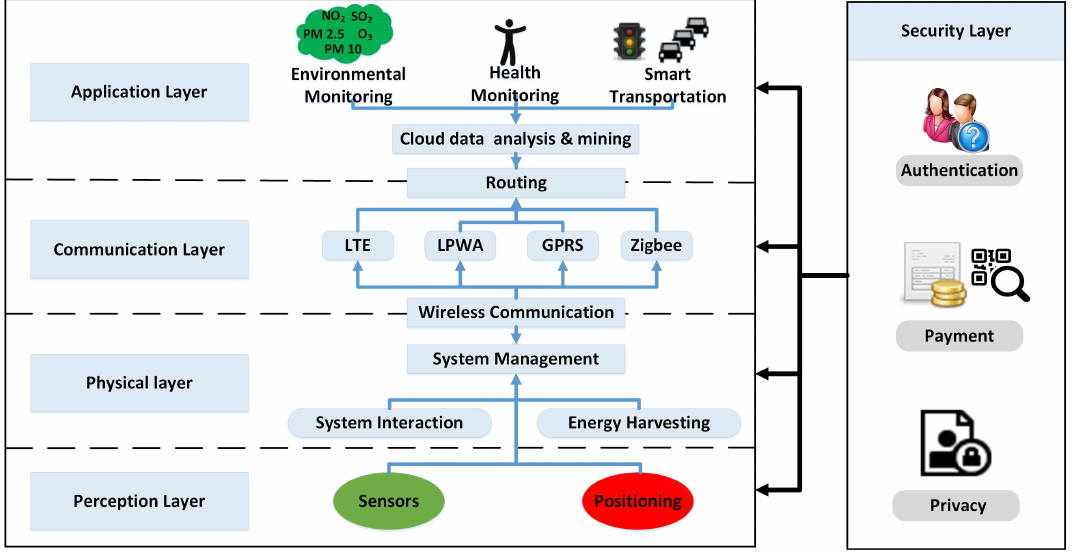
Figure 6. Proposed architecture of